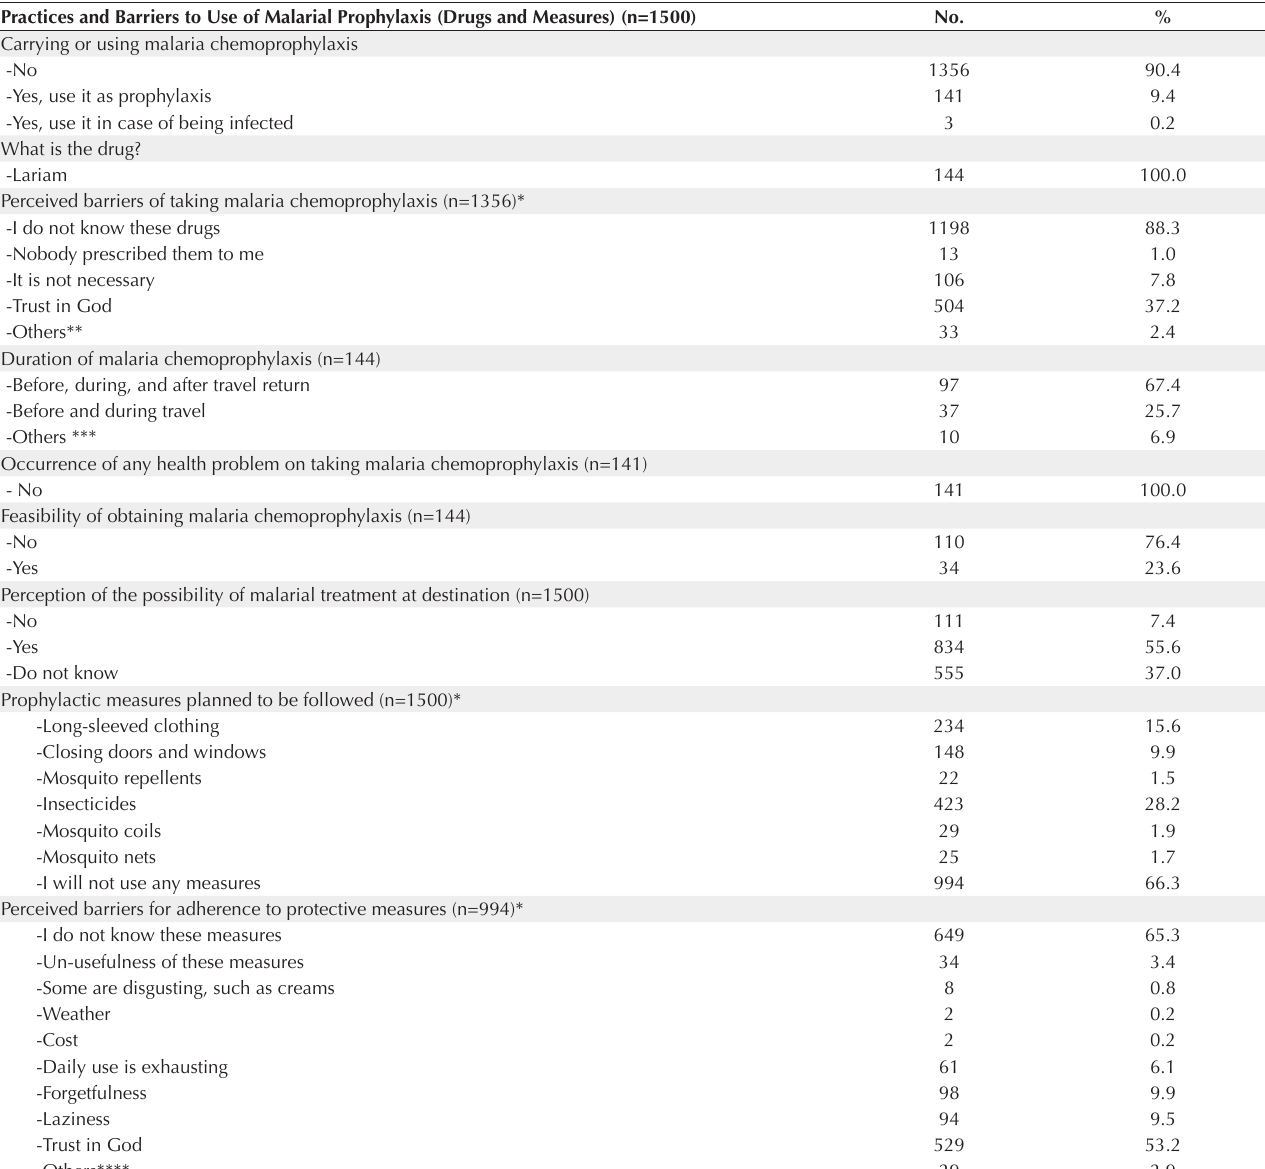
Table 4. Distribution of Travelers at Cairo International Airport Regarding Practices and Barriers of Malarial Prophylaxis (Drugs and Measures) Practices and Barriers to Use of Malarial Prophylaxis (Drugs and Measures) (n=1500)